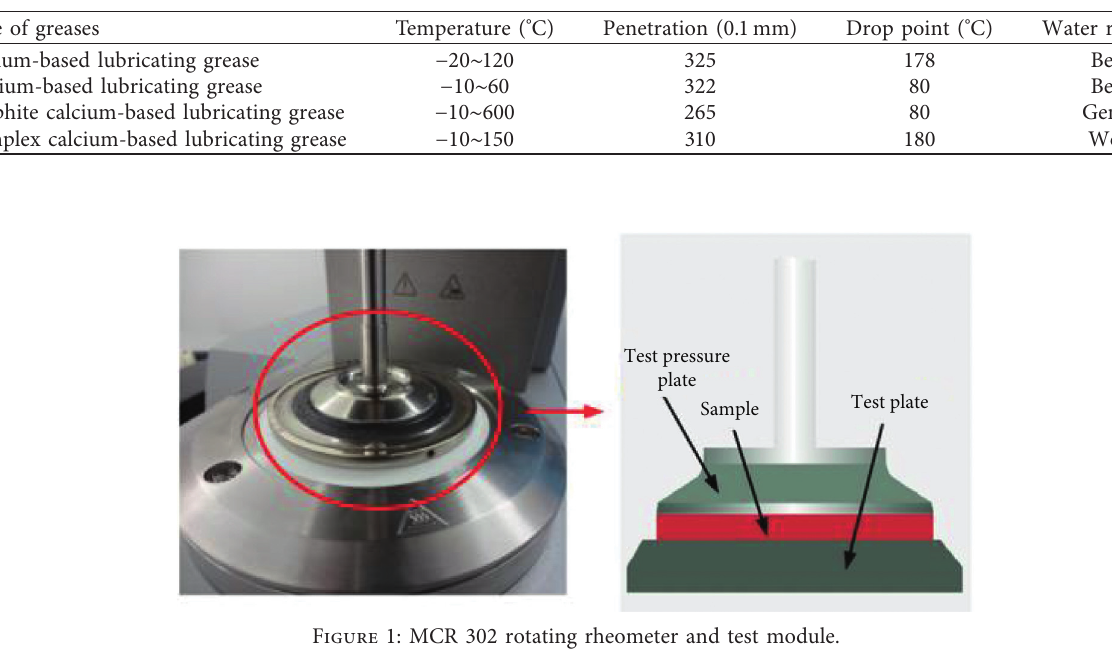
Table 1: Performance parameters of various lubricating